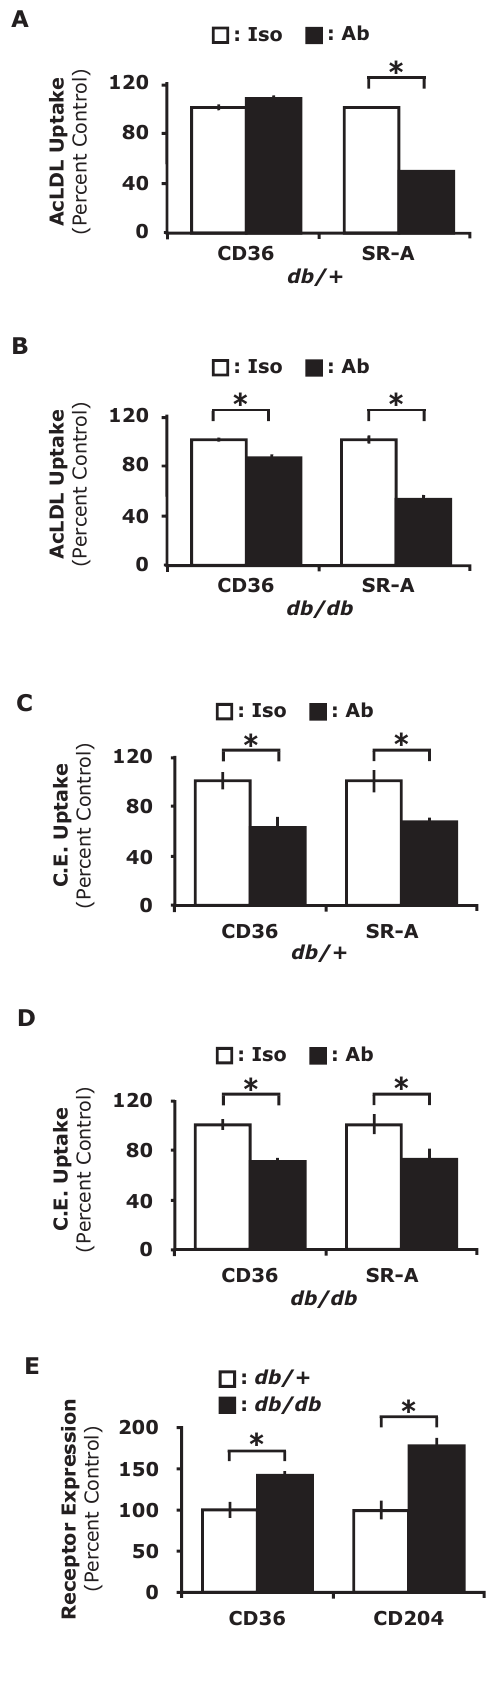
Figure 3. CD36 and SR-A mediate increased AcLDL and cholesteryl ester uptake in diabetic PerM W s. A, PerM W s were collected from db / + mice and cultured for 30 min ex vivo. Cells were then incubated on ice for 15 m with CD36, SR-A blocking antibodies (Ab) or isotype control antibodies (Iso) as indicated. Cells were then incubated with 5 m g/ml Dil-AcLDL and uptake measured by flow cytometry at 4 h. B, PerM W s were collected from db/db mice and cultured for 30 min ex vivo. Cells were then incubated on ice for 15 m with CD36, SR-A blocking antibodies (Ab) or isotype control antibodies (Iso) as indicated. Cells were then incubated with 5 m g/ml Dil-AcLDL and uptake measured by flow cytometry at 4 h. C, Db / + mice were IP administered 5 m g/ml bodipy-cholesteryl ester (C.E.) with CD36, SR-A blocking antibodies (Ab) or isotype control antibodies (Iso) as indicated. After 4 h, PerM W s were collected and cholesteryl ester uptake measured by flow cytometry. D, Db/db mice were IP adminsitered 5 m g/ml bodipy-cholesteryl ester (C.E.) with CD36, SR-A blocking antibodies (Ab) or isotype control antibodies (Iso) as indicated. After 4 h, PerM W s were collected and cholesteryl ester uptake measured by flow cytometry. E , PerM W s were collected from db / + and db/db mice. CD36 and SR-A surface expression was measured by flow cytometry. Results for A-E represent the average of three independent experiments 6 SEM. *: p , 0.05